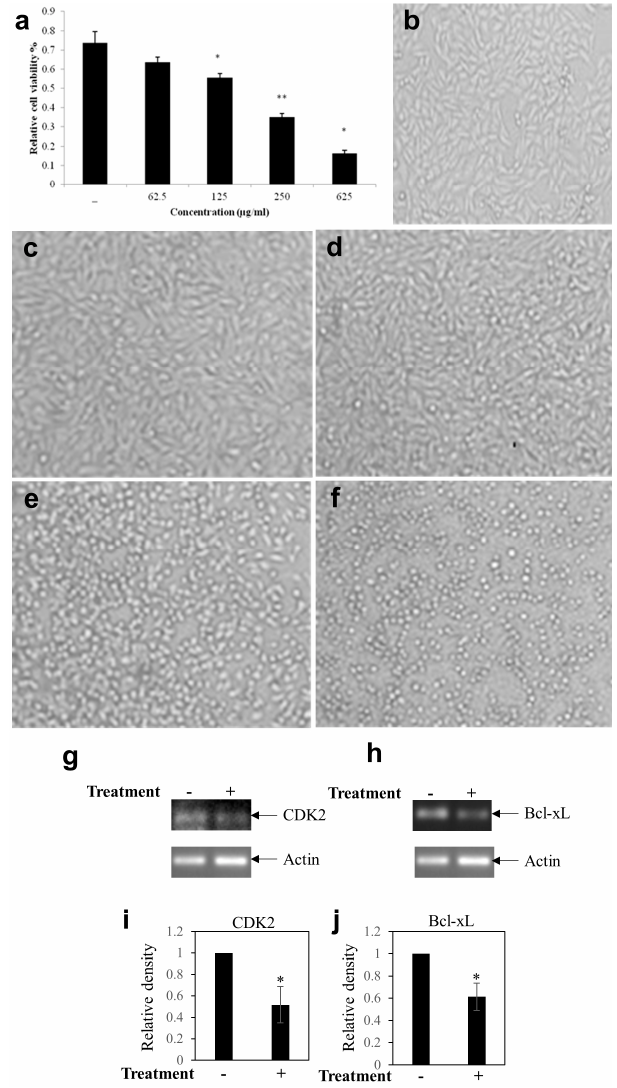
Figure 5. Effect of BEP (Broth extract of Piscibacillus sp.) on MDA-MB-231 cell viability and cell cycle associated genes of breast cancer cell ( a ) Effect of various concentrations (as shown in graph) of BEP on MDA-MB-231 cell viability. Results are the mean of three independent measurements. Significant differences were determined by one-way ANOVA, * p < 0.05 and ** p < 0.01 vs control. ( b – f ) Images of MDA-MB-231 cells morphology after treatment with increasing concentration (0, 62.5, 125, 250 and 625 µ g/mL) of BEP. RT-PCR analysis from the total RNA extracted from BEP treated and untreated cells ( g ) CDK2 gene and ( h ) anti-apoptotic Bcl-xL gene. Bars ( i , j ) showed the densitometry analysis (ratio of concerned gene/Actin) of the bands for CDK2 ( i ) and Bcl-xL ( j ). Reported values represent the mean ± SEM of three replicates. * p < 0.05 vs. control. The expression of CDK2 and Bcl-xL was found to be downregulated in the treatment as compared to the control. Actin was considered as the internal loading control.